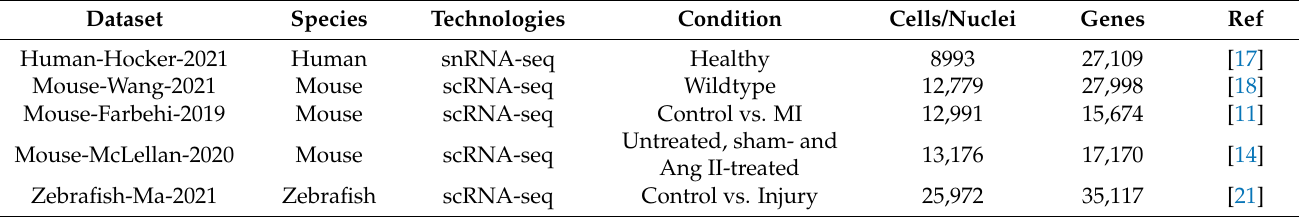
Table 1. Datasets incorporated in ExpressHeart. All three datasets are generated from 10 × Genomics Chromium.